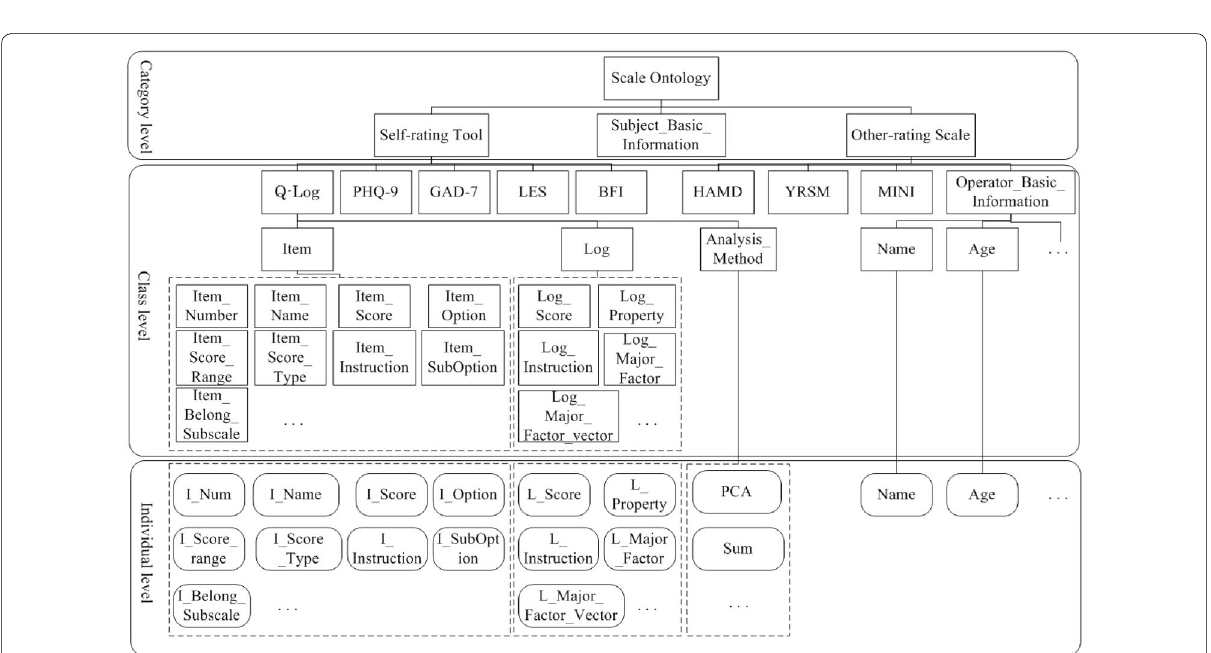
Fig. 3 The structure of clinical evaluation tool ontology for